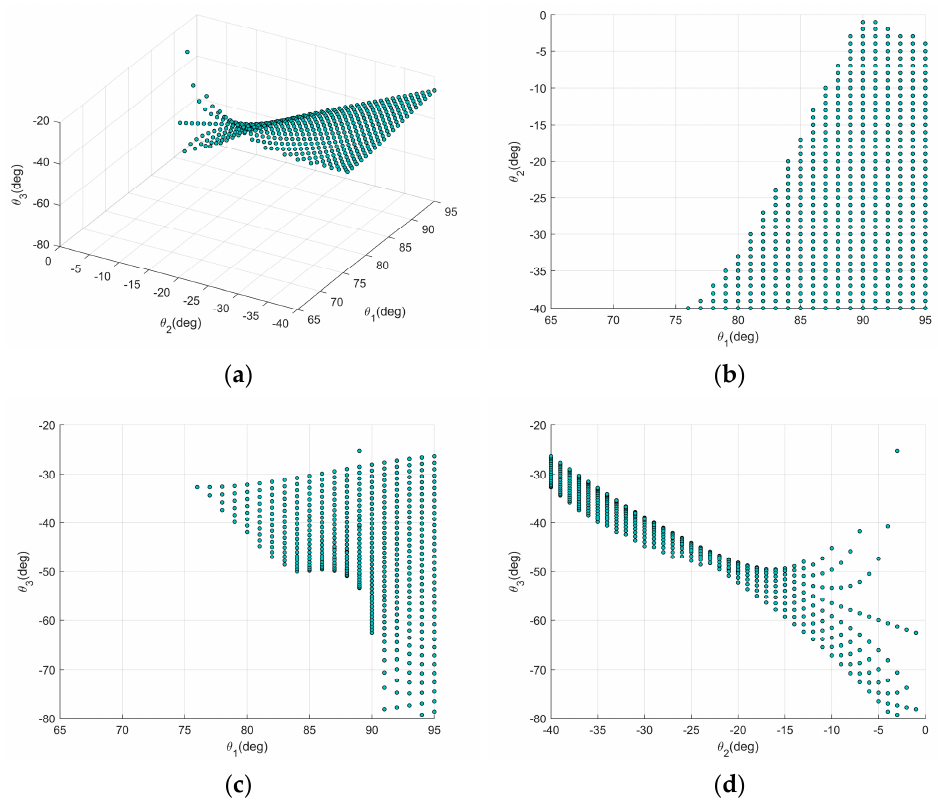
Figure 4. Static Equilibrium Workspace of 0 − 0 − 2 unconstrained cable-driven planar hybrid robot. ( a ) 3D Static Equilibrium Workspace; ( b ) 𝜃 1 𝜃 2 planar view of Static Equilibrium Workspace; ( c ) 𝜃 1 𝜃 3 planar view of Static Equilibrium Workspace; ( d ) 𝜃 2 𝜃 3 planar view of Static Equilibrium Workspace.